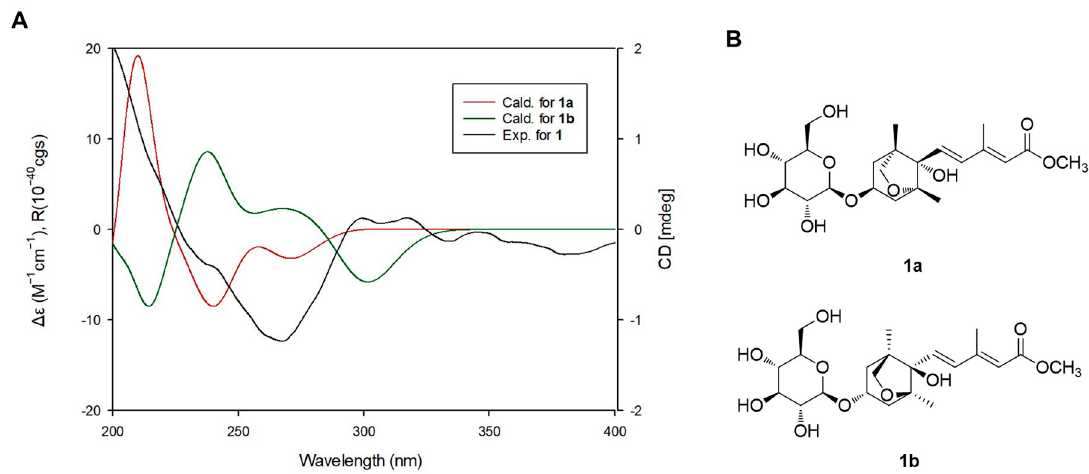
Figure 4. ( A ) Experimental and calculated electronic circular dichroism (ECD) spectra of compound 1 and ( B ) the structures of 1a and 1b .